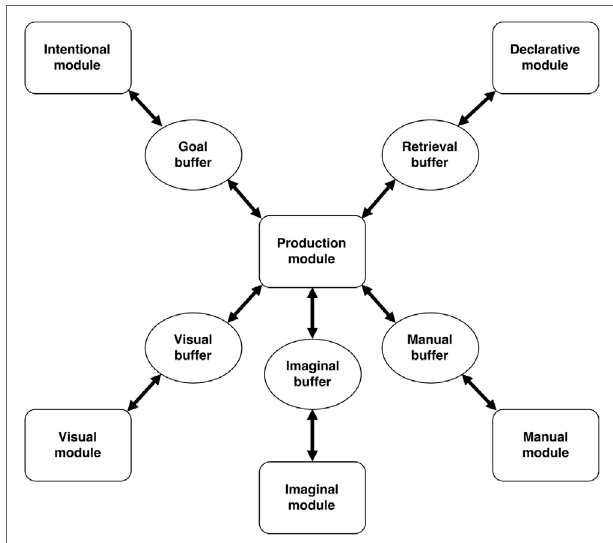
FigURe 2 | An overview of the standard modules and buffers in Adaptive Control of Thought—Rational [based on Anderson et al.